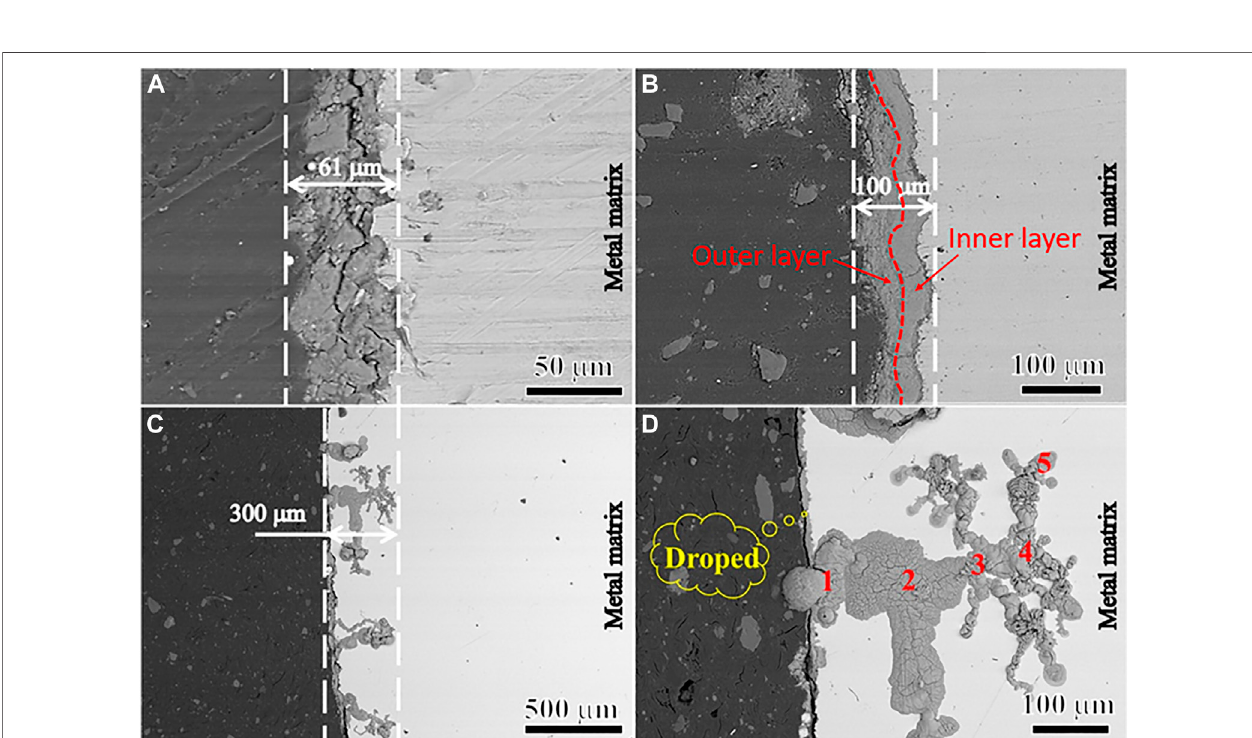
FIGURE 9 | Cross-sectional morphology of N80 steel scale-substrate interface under CO 2 and CO 2 -O 2 conditions: (A) CO 2 − 2.5 MPa; (B) (C) (D) CO 2 − 2.5 MPa, O 2 − 0.5